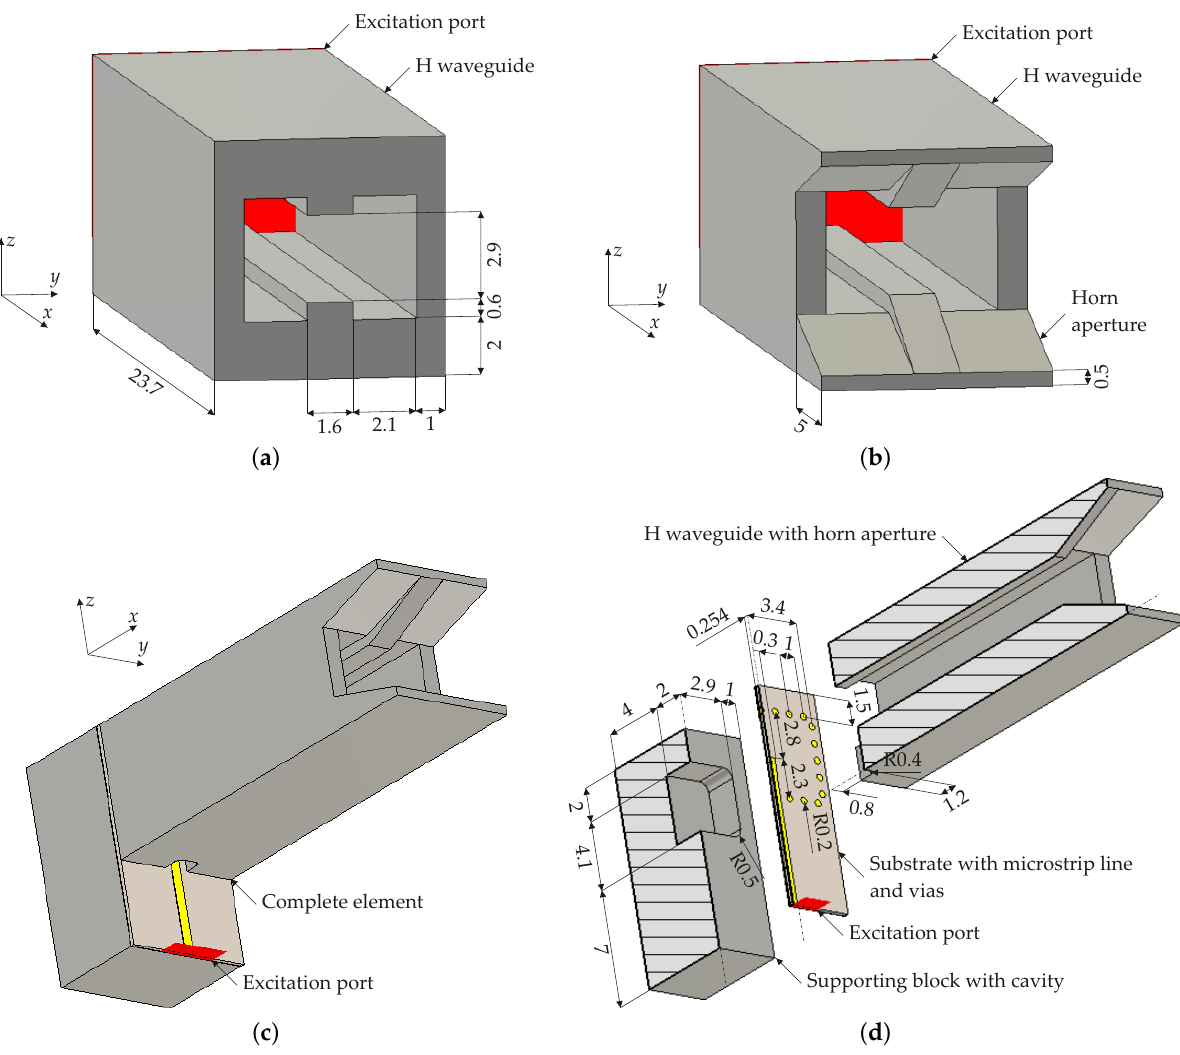
Figure 1. Design steps of element of antenna array: ( a ) the H waveguide, ( b ) the H waveguide with horn aperture, ( c , d ) the complete element, i.e., the H waveguide with horn aperture, supporting block with cavity, and microstrip line. Dimensions are in